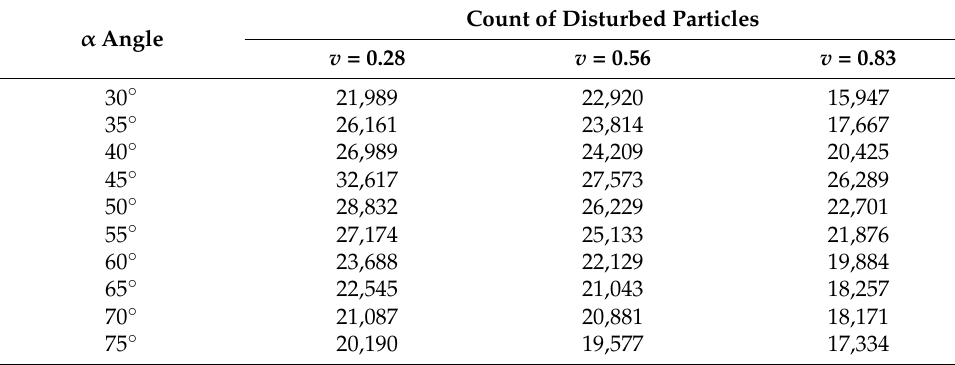
Table 4. Table of statistical results of disturbed particles.